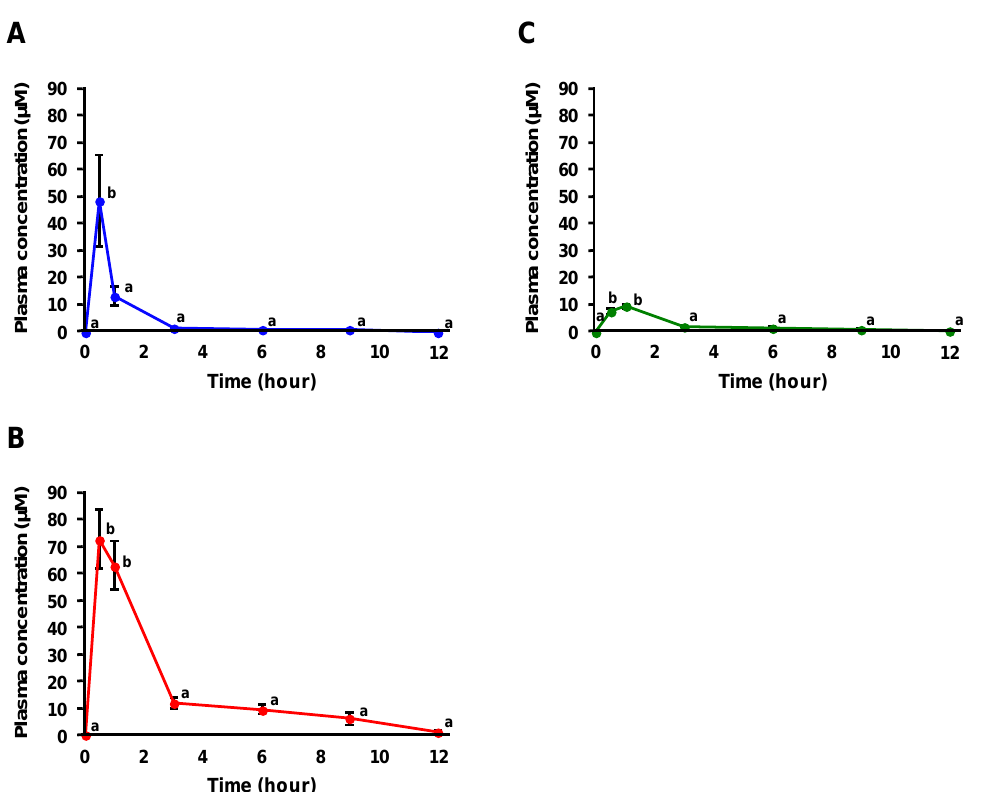
Figure 6. Time-dependent changes in plasma concentrations (µM) of FA and FA conjugates (FA ( A ), FAS ( B ), and FAG ( C )) after FA administration. Data are shown as means ± SE ( n = 6) and different letters represent significant difference at p < 0.05.